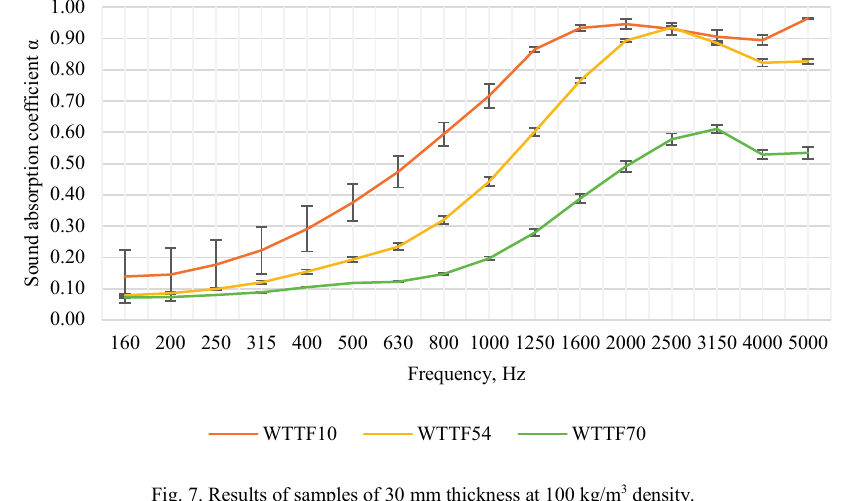
Fig. 7. Results of samples of 30 mm thickness at 100 kg/m 3 density.